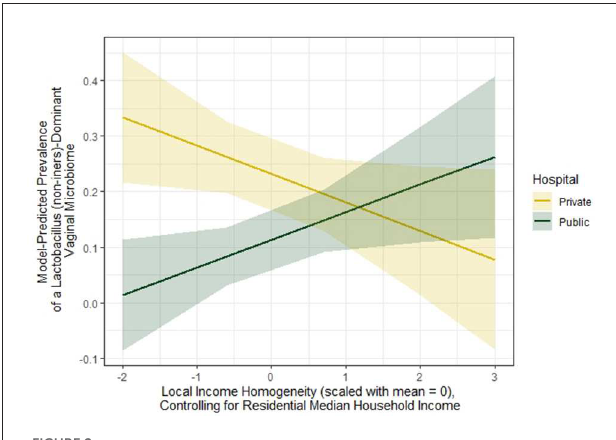
FIGURE2 Illustrative interaction of crossover